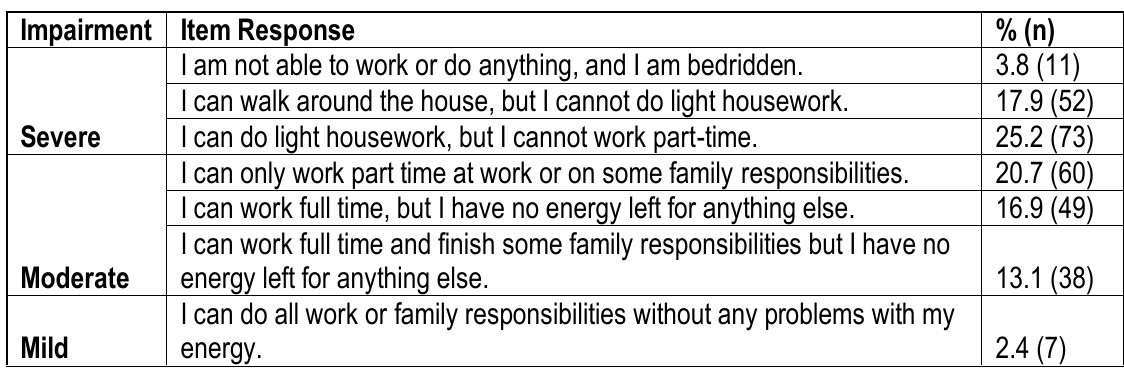
Table 1. Item responses, level of impairment, and frequency to the DSQ question: Which statement best